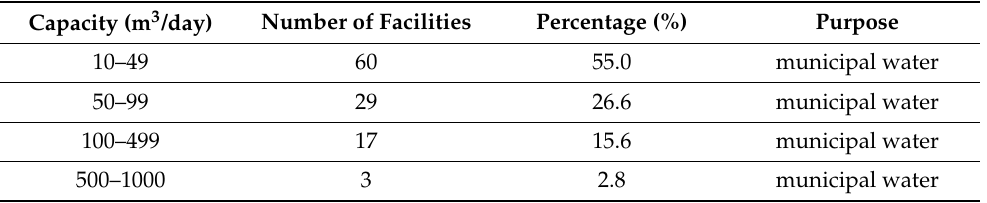
Table 2. Capacity of seawater RO desalination facilities for municipal water on islands of South